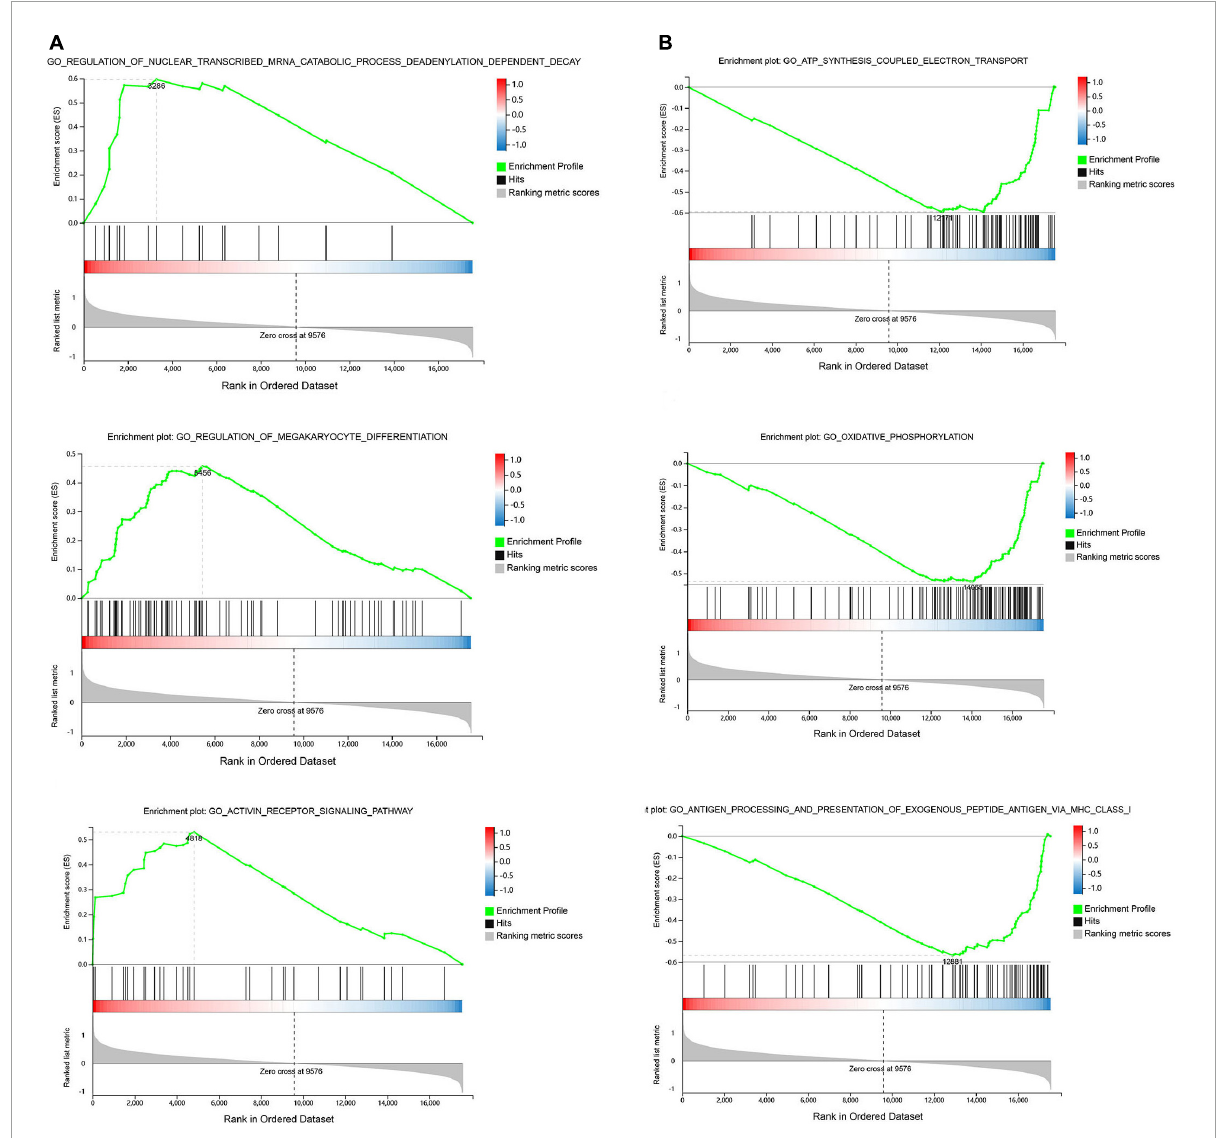
FIGURE3 Enrichment analyses via gene set enrichment analysis (GSEA). (A) The top three enriched up-regulated GO gene sets. (B) The top three enriched down-regulated GO gene